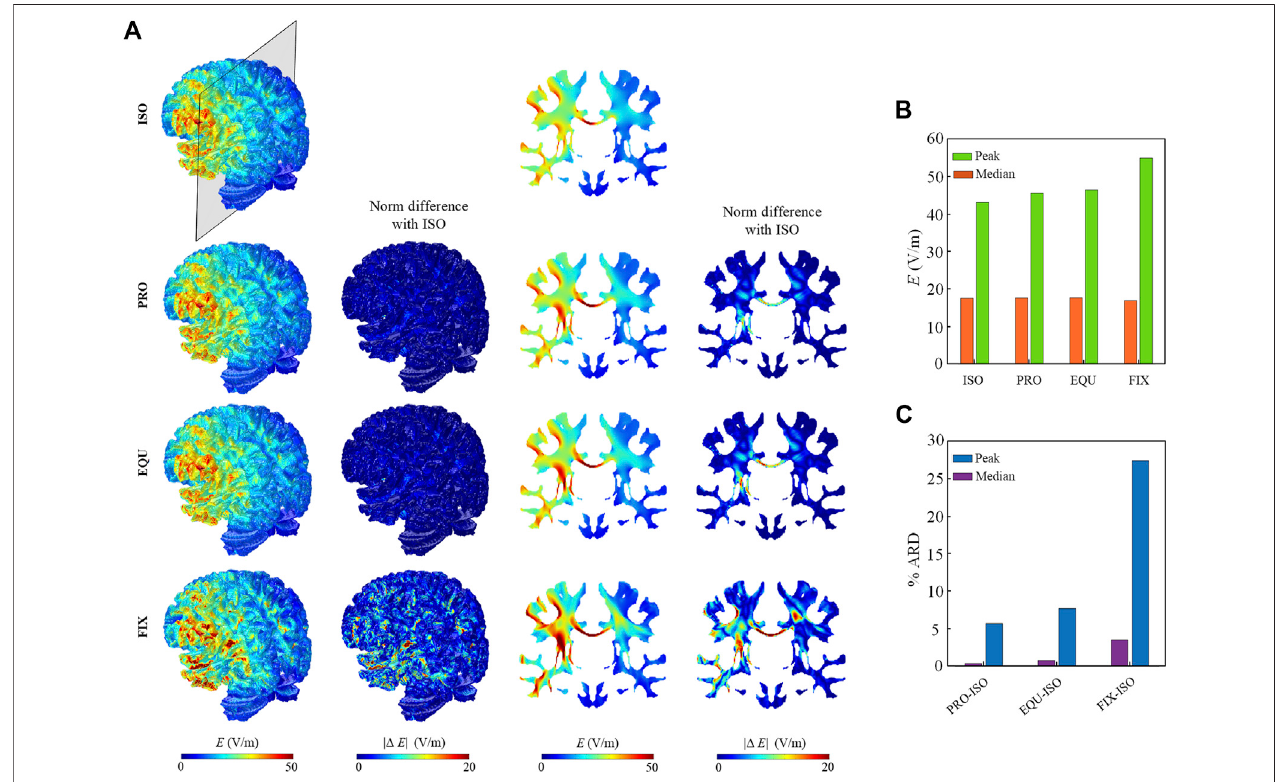
FIGURE 4 | (A) Electric fi eld distribution across the WM in the isotropic (ISO) and three anisotropic models (PRO, EQU, FIX). The fi rst and third columns show the distribution of the electric fi eld on the WM surface and coronal planes. The second and fourth columns show the norm of difference in the anisotropic models relative to the isotropic model. (B) Peak and median values of electric fi eld for WM in the left hemisphere for four models. (C) The percent ARD between isotropic and each anisotropic model for peak and median